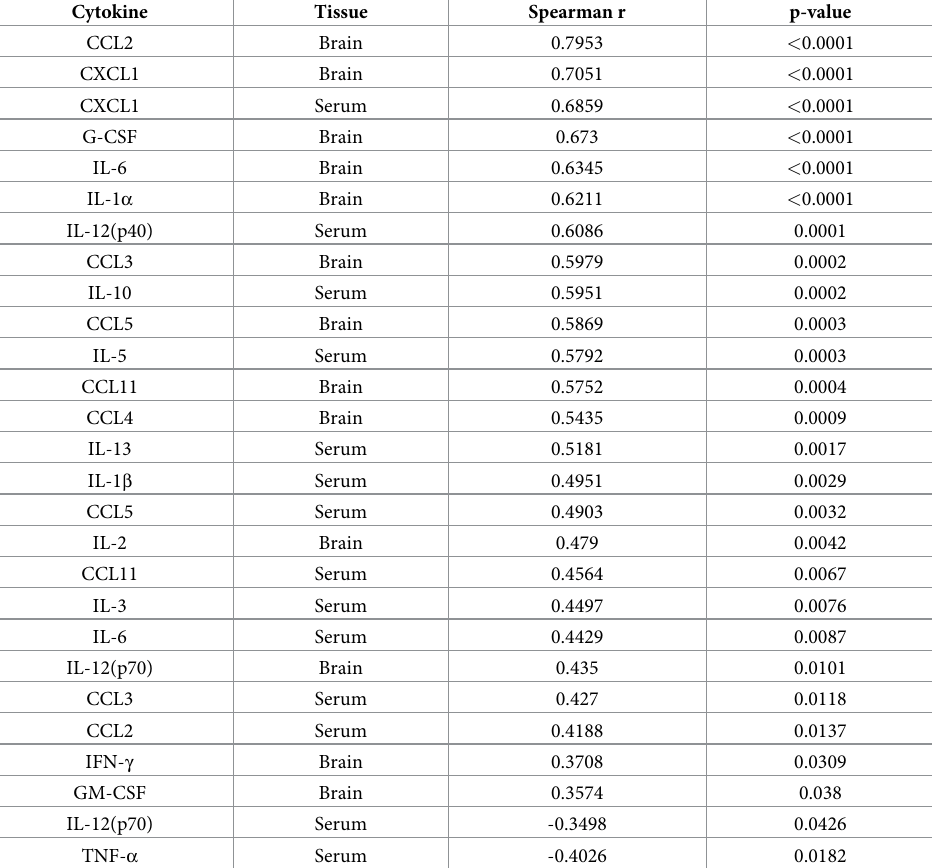
Table 6. Correlations of 99mTc-DTPA brain/serum ratios with brain and serum cytokines in LPS-treated